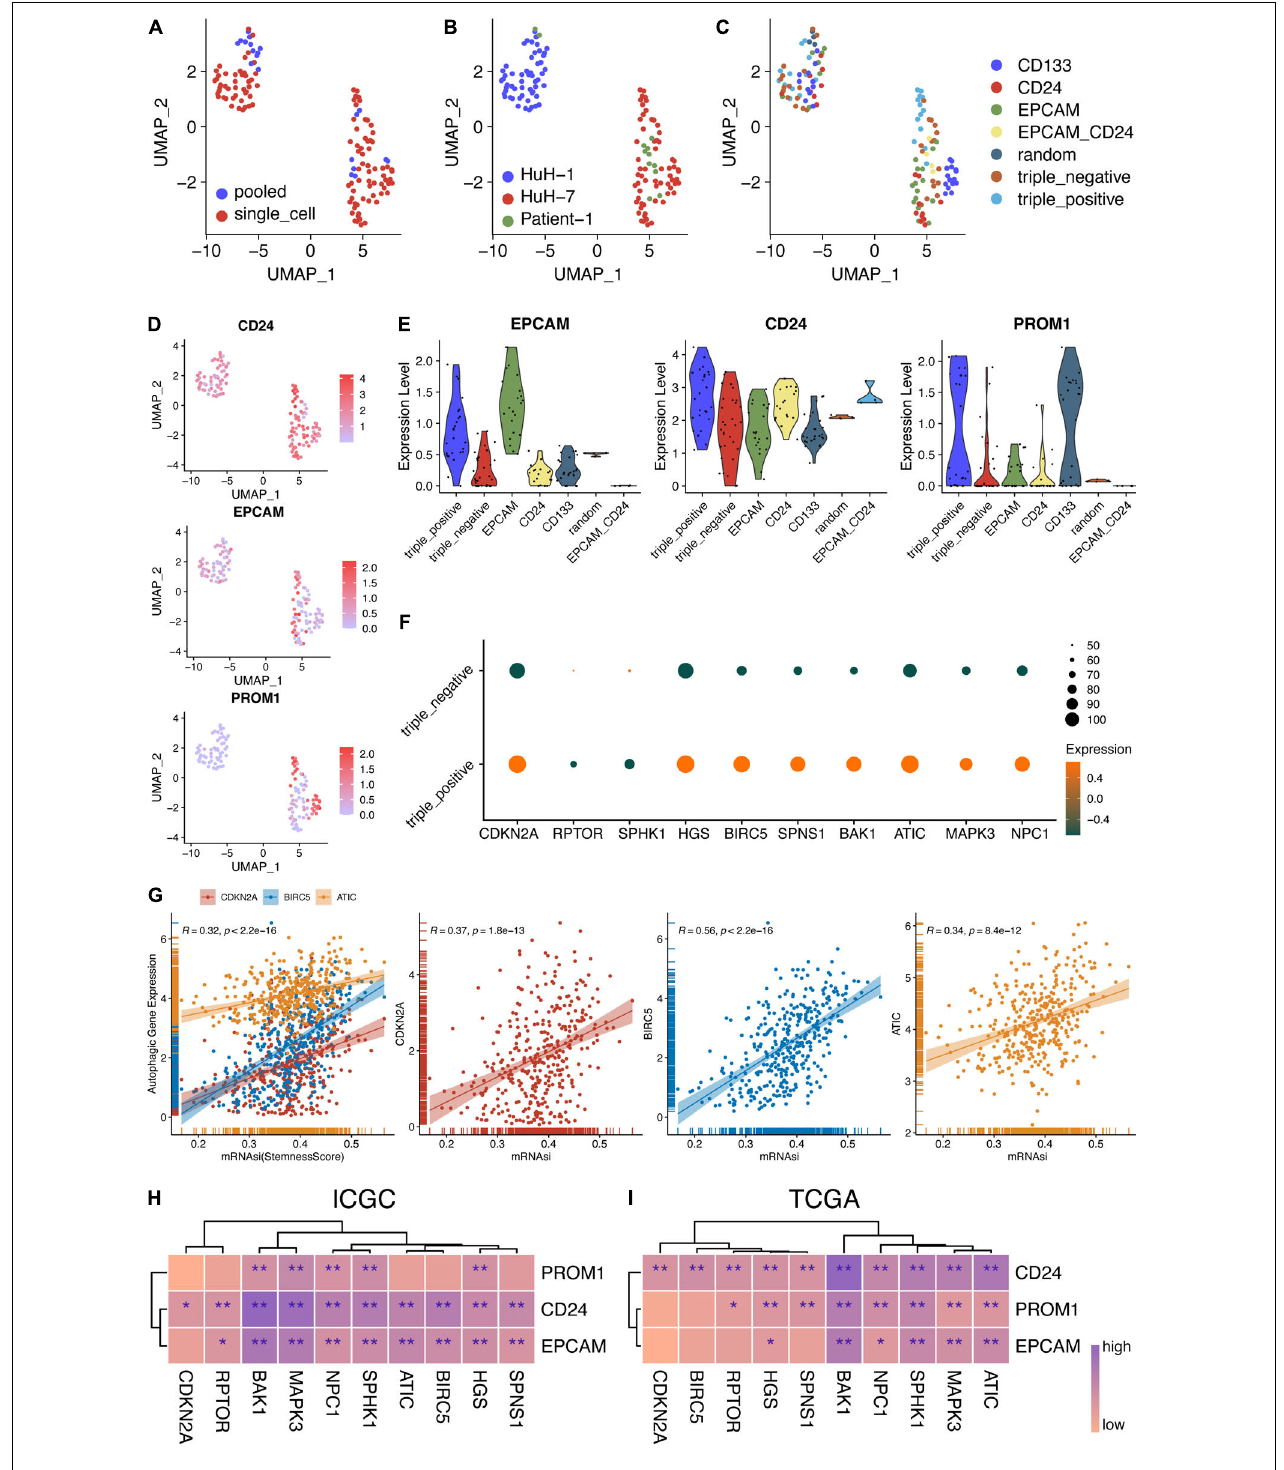
FIGURE 5 | Stemness analysis of 10 hub genes in bulk and single-cell RNA-seq data. (A–C) UMAP plot of 130 single cells using different classifications. (D) Expression levels of three CSC markers in single-cell and pooled-cell samples. (E) The expression levels of the three CSC markers were consistent with the FACS-sorting results. (F) Expression levels of 10 autophagy genes in triple-negative and triple-positive samples. (G) Correlation analysis between autophagy genes and stemness scores in TCGA-LIHC patients. (H) Correlation analysis between 10 autophagy genes and three CSC markers in the ICGC database. (I) Correlation analysis between 10 autophagy genes and three CSC markers in the TCGA database. * P < 0.05 and ** P < 0.01.